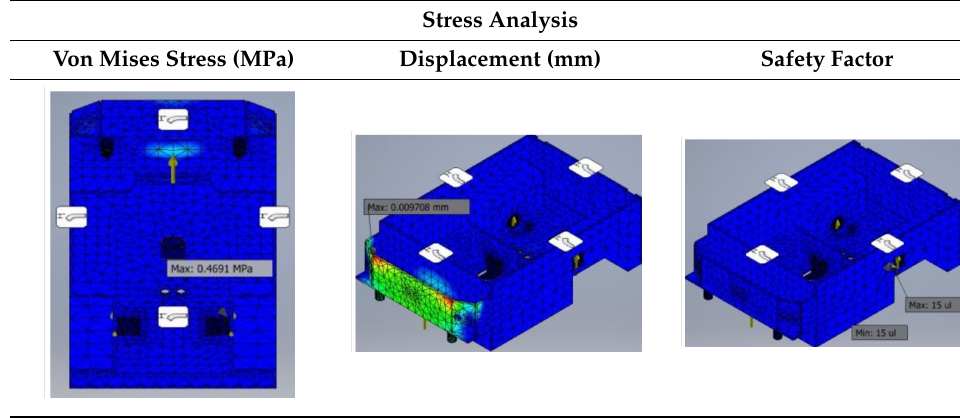
Table 22. Stress simulation results for the prototype.